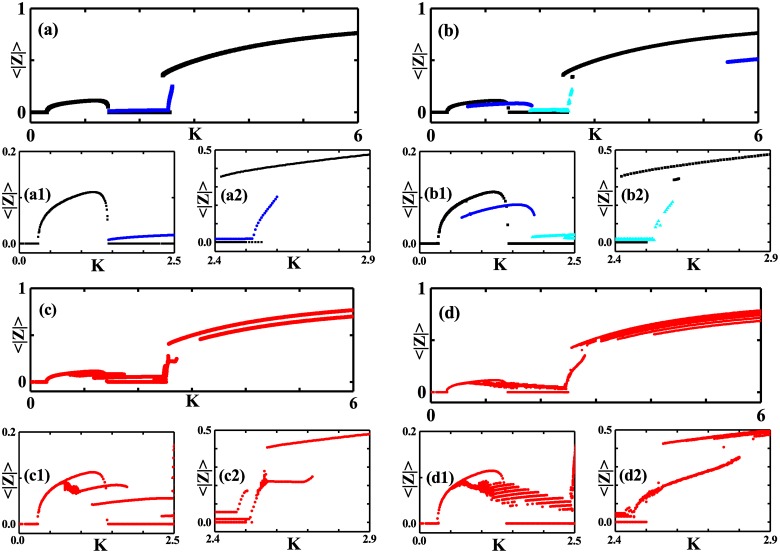
〈|Z|〉 against K for initial conditions taking the form of u1,2(x, t)∼eiqx with different integers q.(a) σ = 0.4. q = 0 in black and q = 1 in blue. (b) σ = 0.2. q = 0 in black, q = 1 in blue and q = 2 in cyan. (c) σ = 0.1 and red for q. (d) σ = 0.02 and red for q. The magnifications for the range of K ∈ (0, 2.5) are presented in (a1-d1) and for the range of K ∈ (2.4, 2.9) in (a2-d2). γ1 = 1, γ2 = 0.01, α = 0.8, and p = 0.9.